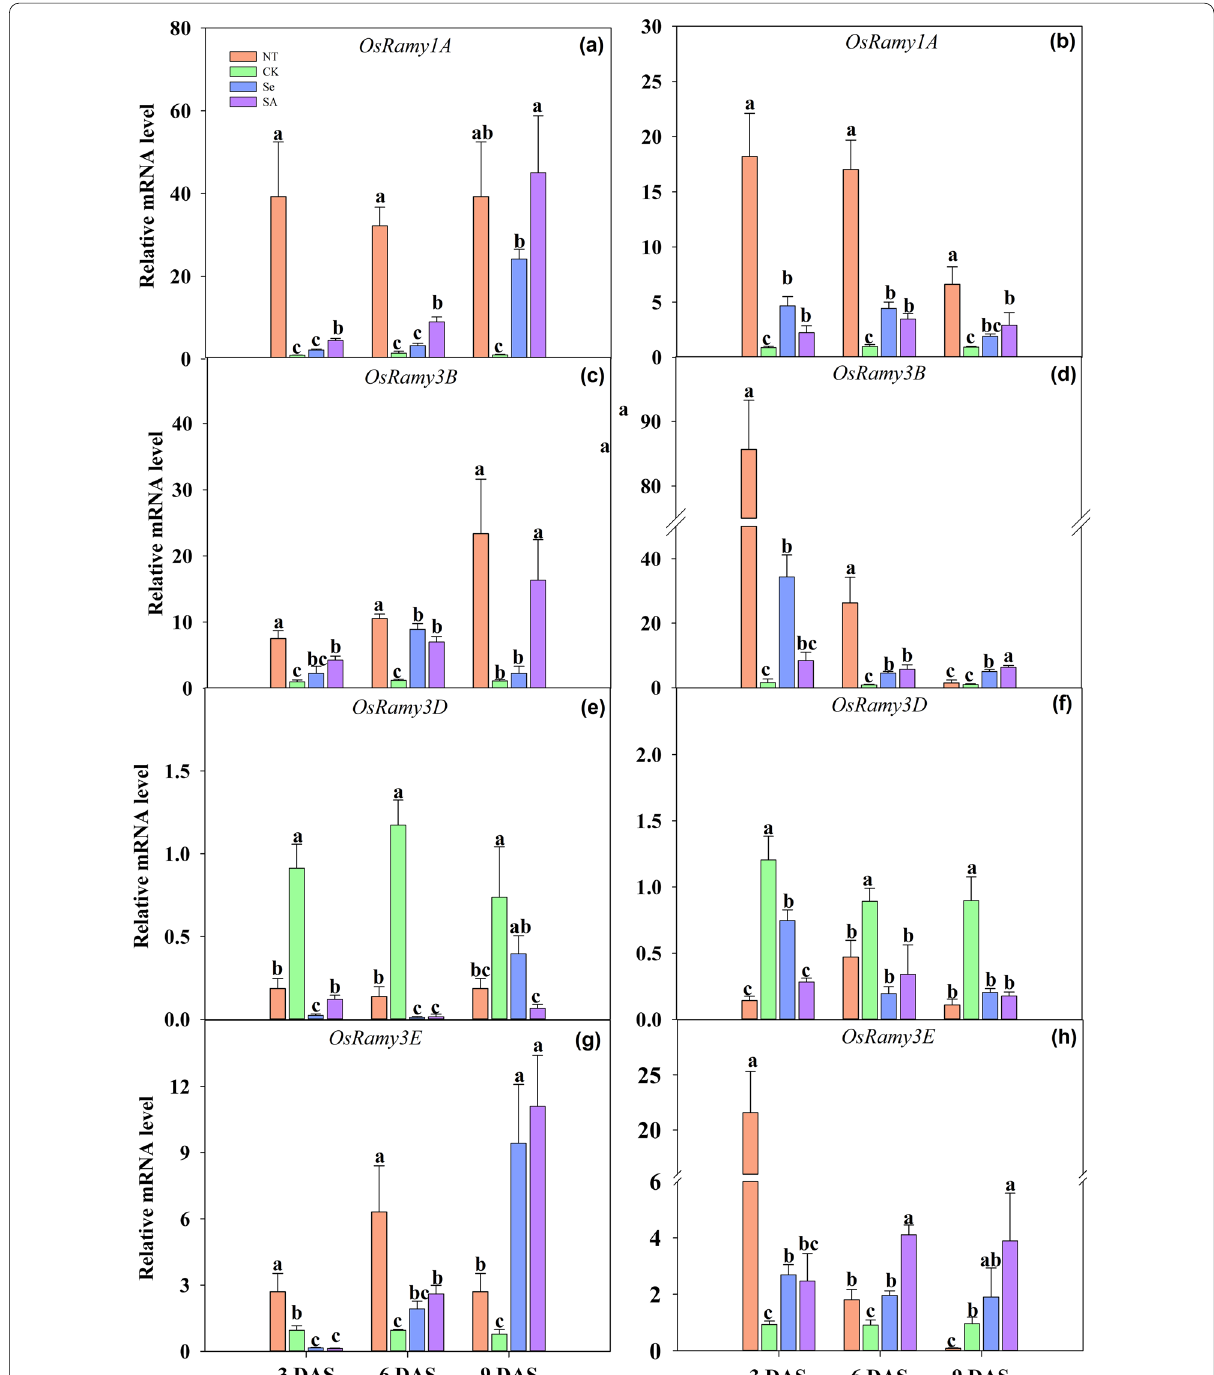
Fig. 4 Relative expression levels of α-amylase genes of primed and non-primed rice seeds under control temperature and chilling stress. a, c, e, g EZ18; b, d, f, h LY287; a, b OsRamy1A ; c, d OsRamy3B ; e, f OsRamy3D ; g, h OsRamy3E ; DAS, days after sowing; EZ18, ezao18; LY287, liangyou287; NT, no priming-normal temperature control; CK, no priming-chilling stress; Se, Selenium priming-chilling stress; SA, Salicylic priming-chilling stress. Error bars indicate standard error (n 3). Different lowercase letters denote statistical differences at the 5% level according to LSD test among four = treatments within the same DAS of the same